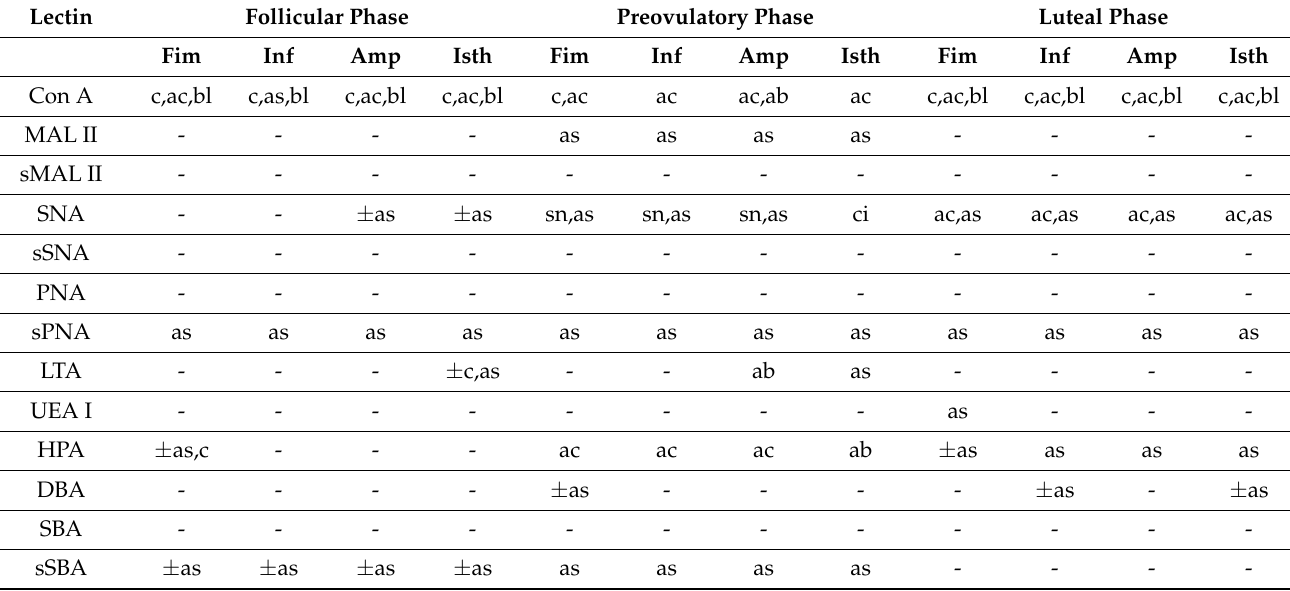
Table 2. Lectin binding pattern of the epithelium lining the baboon Papio hamadryas oviduct during the menstrual